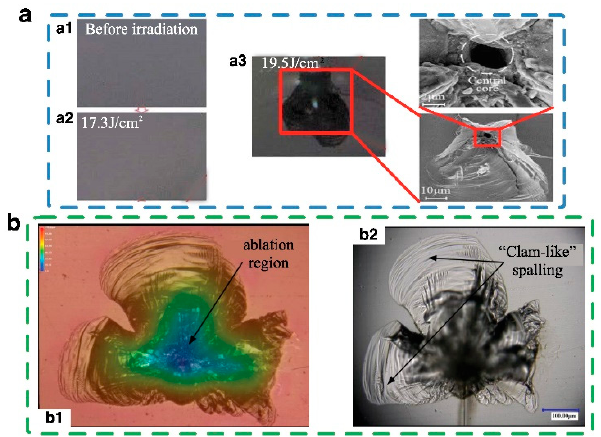
Figure 22. Typical morphology of the laser-induced damage. ( a ) Damage craters under the irradiation of nanosecond laser ( λ = 355 nm) with a1 before irradiation, a2 fluences (17.3 J / cm 2 ), and a3 fluences (19.5 J / cm 2 ) shows the central core [92]; ( b ) Damage under λ = 355 nm, and 6.4 ns pulse duration with b1 reflection 3D scan image and b2 transmission 3D scan image